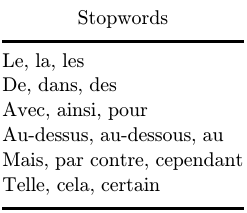
Table 2. Extract from the lemmatization